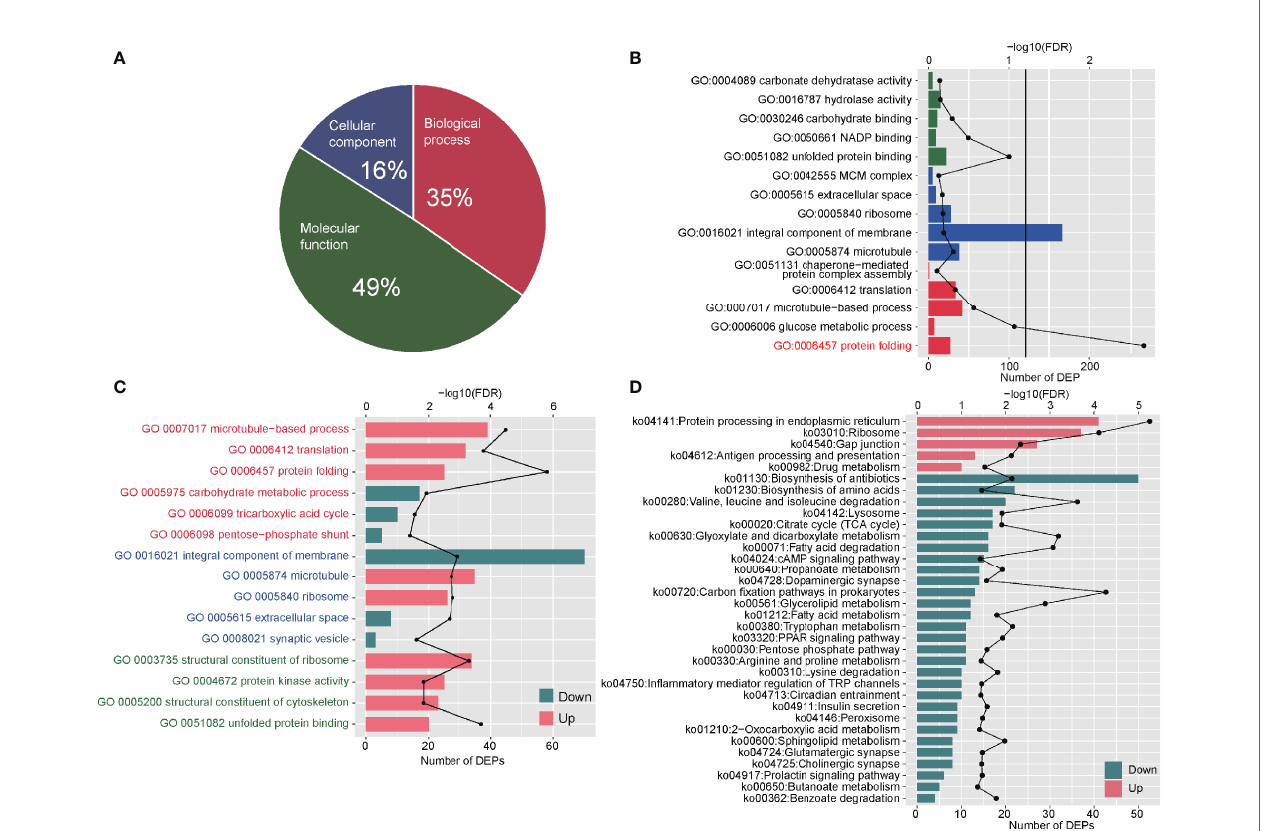
FIGURE 4 | Functional analyses of DEPs between adult stage and metacercariae stage. (A) Demonstrated the classi fi cation of DEPs by cellular component, biological process and molecular function. (B) The DEPs enriched in GO function. The red font indicates the signi fi cant enrichment function. (C) The increased and decreased DEPs enriched in GO function. The red font represents biological process classi fi cation, the blue font represents cellular component classi fi cation, and the green font represents molecular function classi fi cation. (D) The up-regulated DEPs and down-regulated DEPs enriched pathways in KEGG function. The discount graph represents the -log10 value of FDR and only shows the results of FDR <